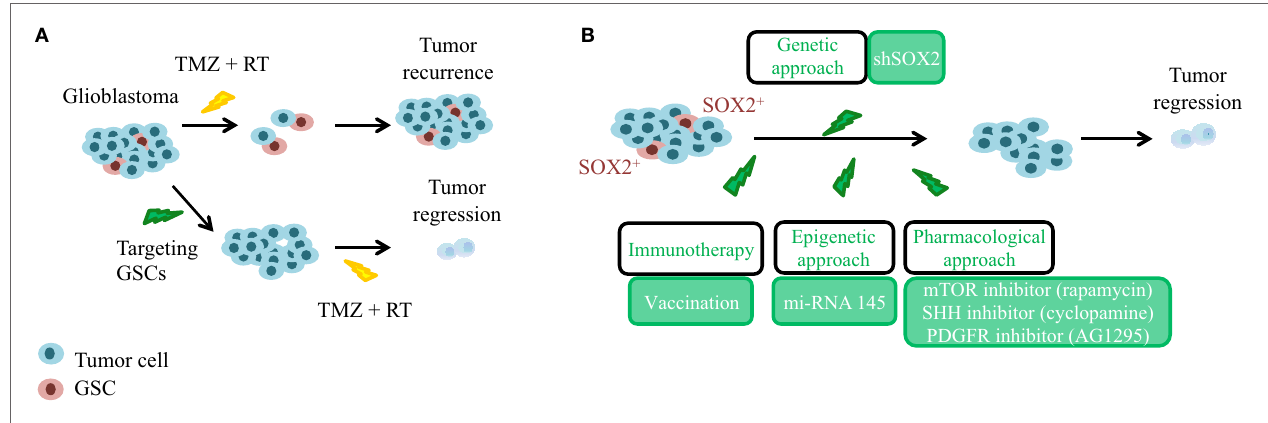
FiGURe 1 | Significance of glioma stem cells (GSCs) and SOX2 targeting in the recurrence of glioblastoma . (A) Glioblastoma is a heterogeneous tumor composed of GSCs (in red, chemo-, and radiotherapy resistant) and of differentiated tumor cells (in blue, chemo-, and radiotherapy responsive). GSCs need to be targeted before current standard approaches to achieve tumor regression. TMZ, temozolomide; RT, radiotherapy. (B) In order to avoid tumor recurrence, genetic, epigenetic, and pharmacological approaches targeting GSCs expressing high levels of SOX2 have been